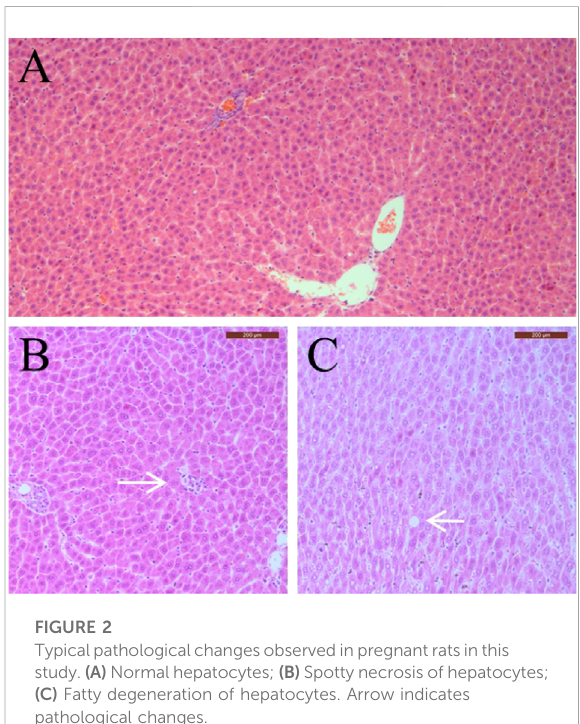
FIGURE 2 Typicalpathologicalchangesobservedinpregnantratsinthis study. (A) Normal hepatocytes; (B) Spotty necrosis of hepatocytes; (C) Fatty degeneration of hepatocytes. Arrow indicates pathological